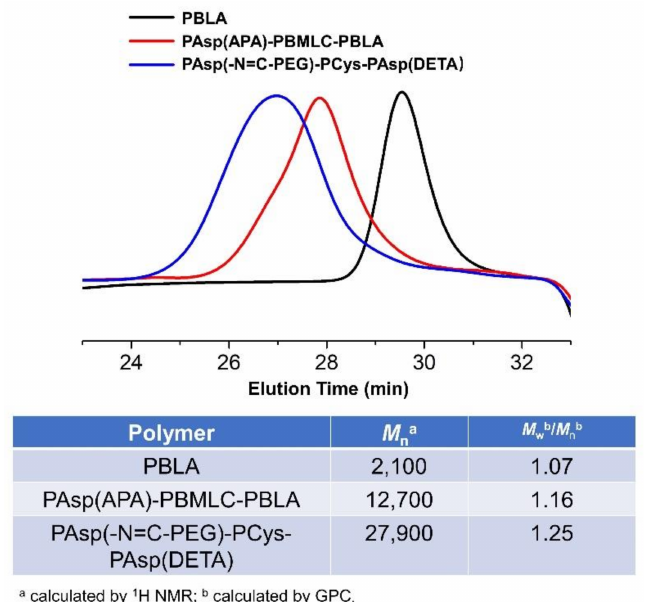
Figure 7. GPC curves, M n and molecular weight distributions of PAsp(-N=C-PEG)-PCys- PAsp(DETA), PAsp(APA)-PBMLC-PBLA, and PBLA. Next, poly(3-azidopropylamine) aspartamide, referred to here as PAsp(APA), was synthesized by ammonolysis reaction between PBLA and 3-azidopropylamine (Figure 2). The 1 H-NMR analysis at 0.85 ppm (t, C H 3 -),1.65 ppm (m, N 3 CH 2 C H 2 -), 2.6–2.9 ppm (d, - CHC H 2 CONH-), 3.0 ppm (s, N 3 C H 2 -) and 4.80 ppm (s, -C H CH 2 CONH-) confirmed the successful synthesis of PAsp(APA) (Figure 6b). In the Fourier transform infrared (FTIR) spectrum of PAsp(APA), the characteristic peaks at 1736 cm − 1 ( v C=O , benzyl ester), and 746 and 696 cm − 1 ( δ Ar-H , benzenoid), of PBLA disappeared, and, at the same time, the characteristic peaks at 2100 cm − 1 ( v -N3 , azide group) appeared, suggesting the successful deprotection of PBLA by ammonolysis with 3-azidopropylamine (Figure 8).